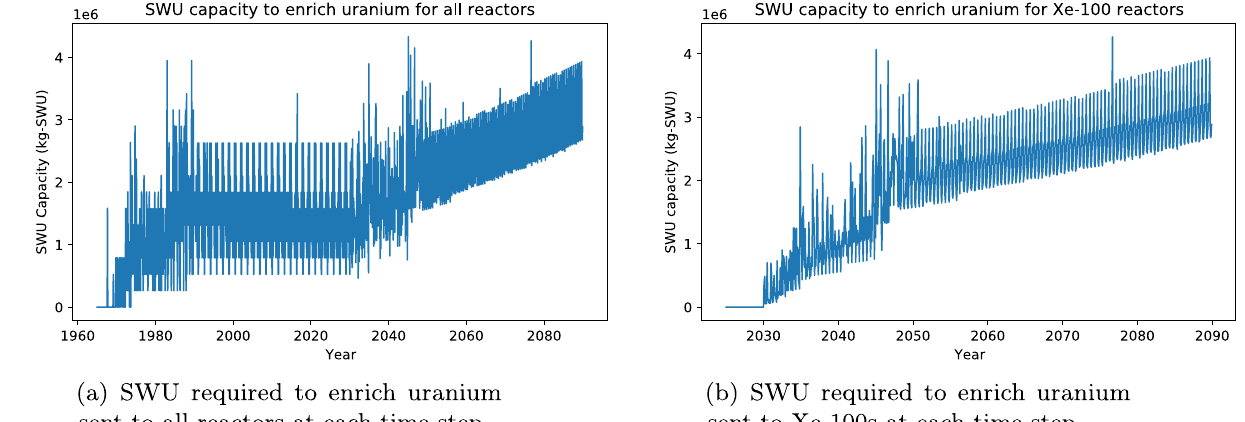
Fig. 16. SWU required to enrich natural uranium in Scenario 5.